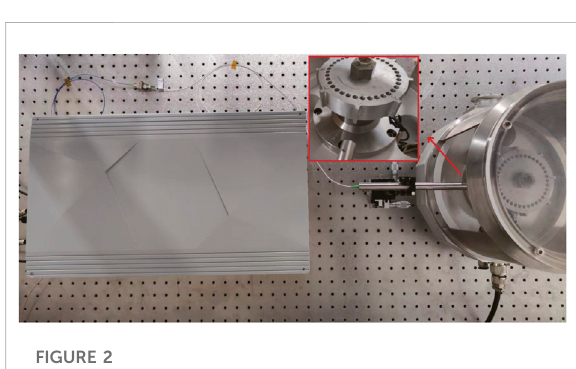
FIGURE 2 The experiment setup for tip clearance measurement system based on